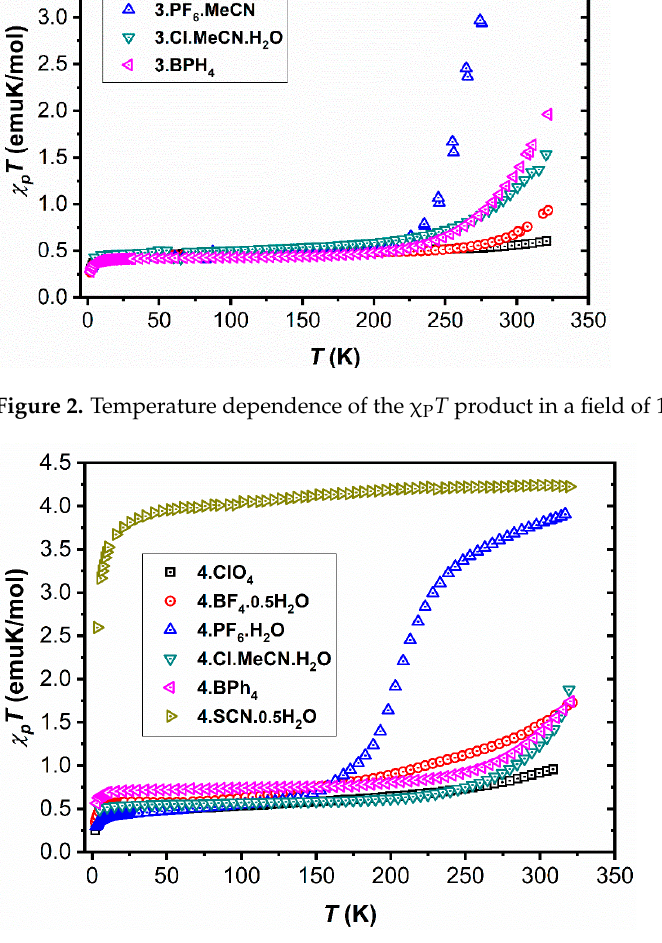
Figure 3. Temperature dependence of the χ P T product in a field of 1 T.